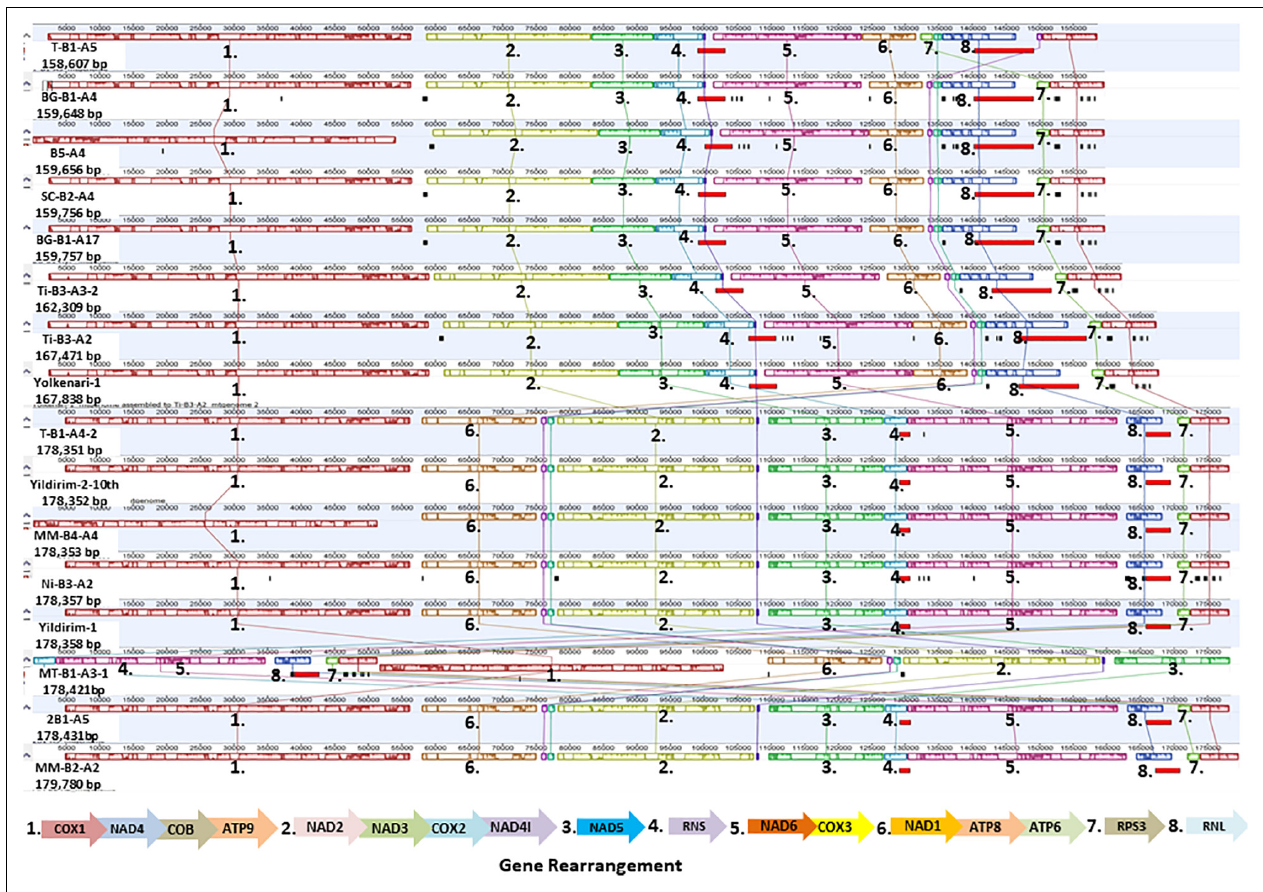
FIGURE 3 | Gene order of 16 mitogenomes of Monilinia isolates is shown. Homologous regions are colored differently and numbered to follow the